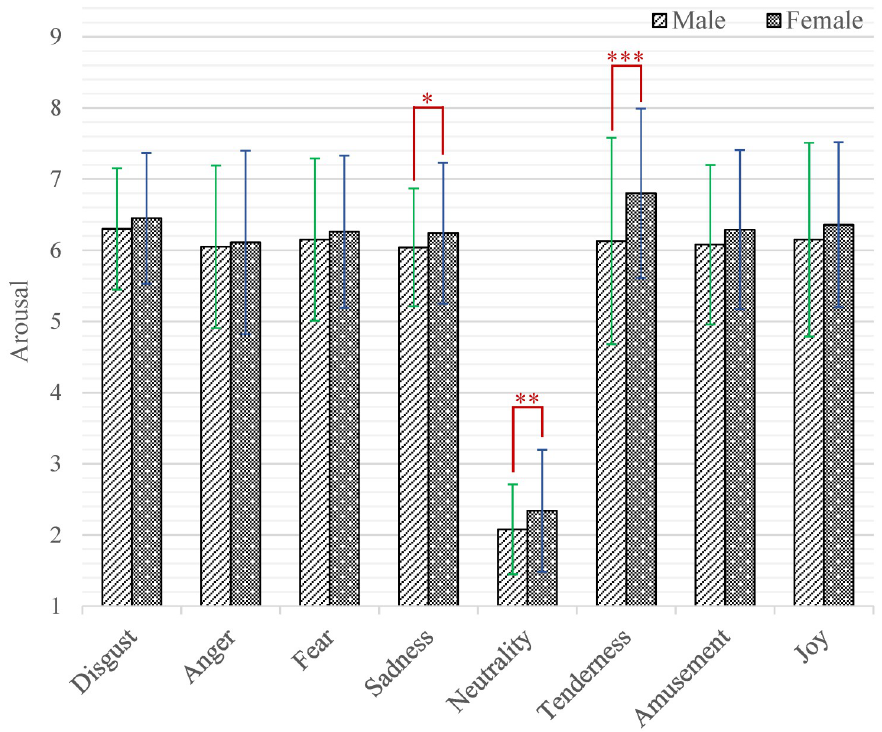
Fig 6. The arousal scores of each category of emotion-inducing short videos between male and female. Statistical significance: * p < 0.05, ** p < 0.01, *** p < 0.001. Unless marked with the asterisk, no significant differences between these groups were